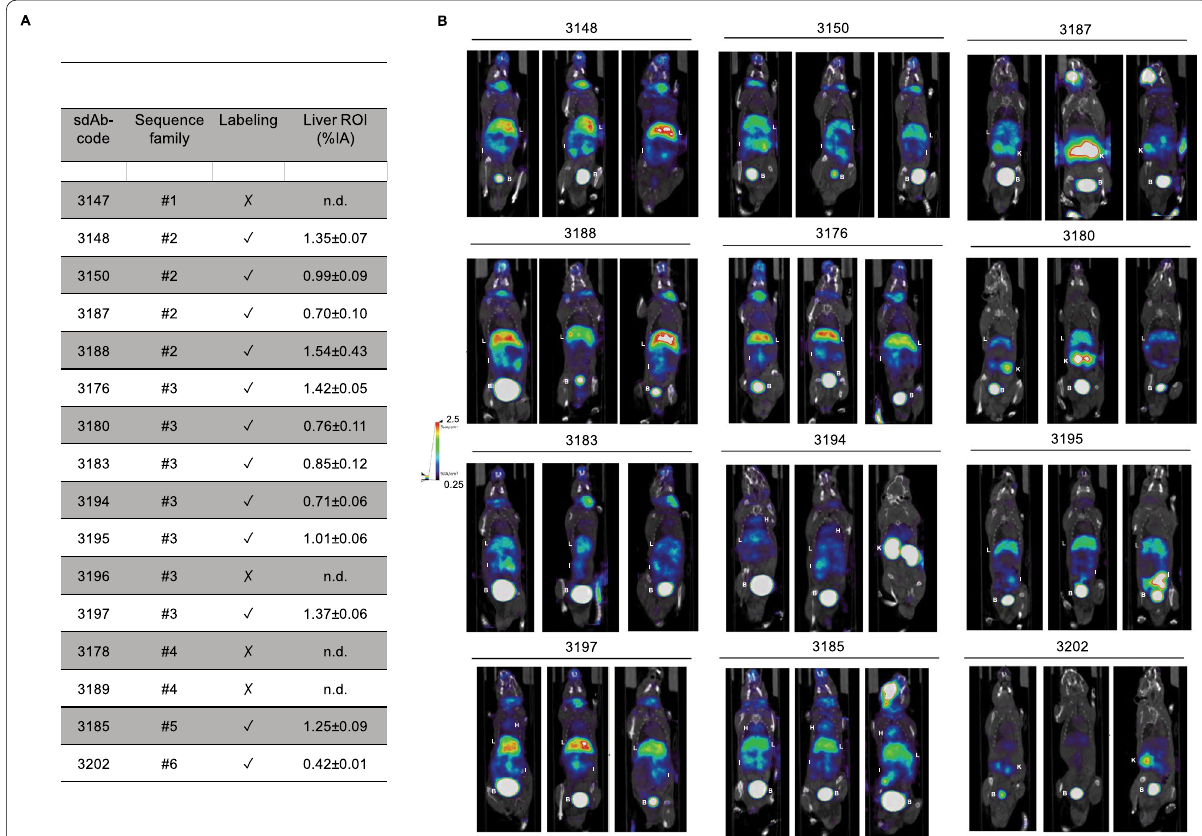
Fig. 3 Biodistribution of selected anti-huLAG-3 sdAbs in healthy mice. A The table shows the code, sequence family, potential of labeling with 99m Tc, and uptake of the tracer in the liver. The successful or unsuccessful labeling of sdAbs with 99m Tc is depicted with ✓ or ✗ respectively. B SPECT/CT images generated 1 h after injection of 99m Tc-labeled sdAbs in healthy C57BL/6 mice ( n